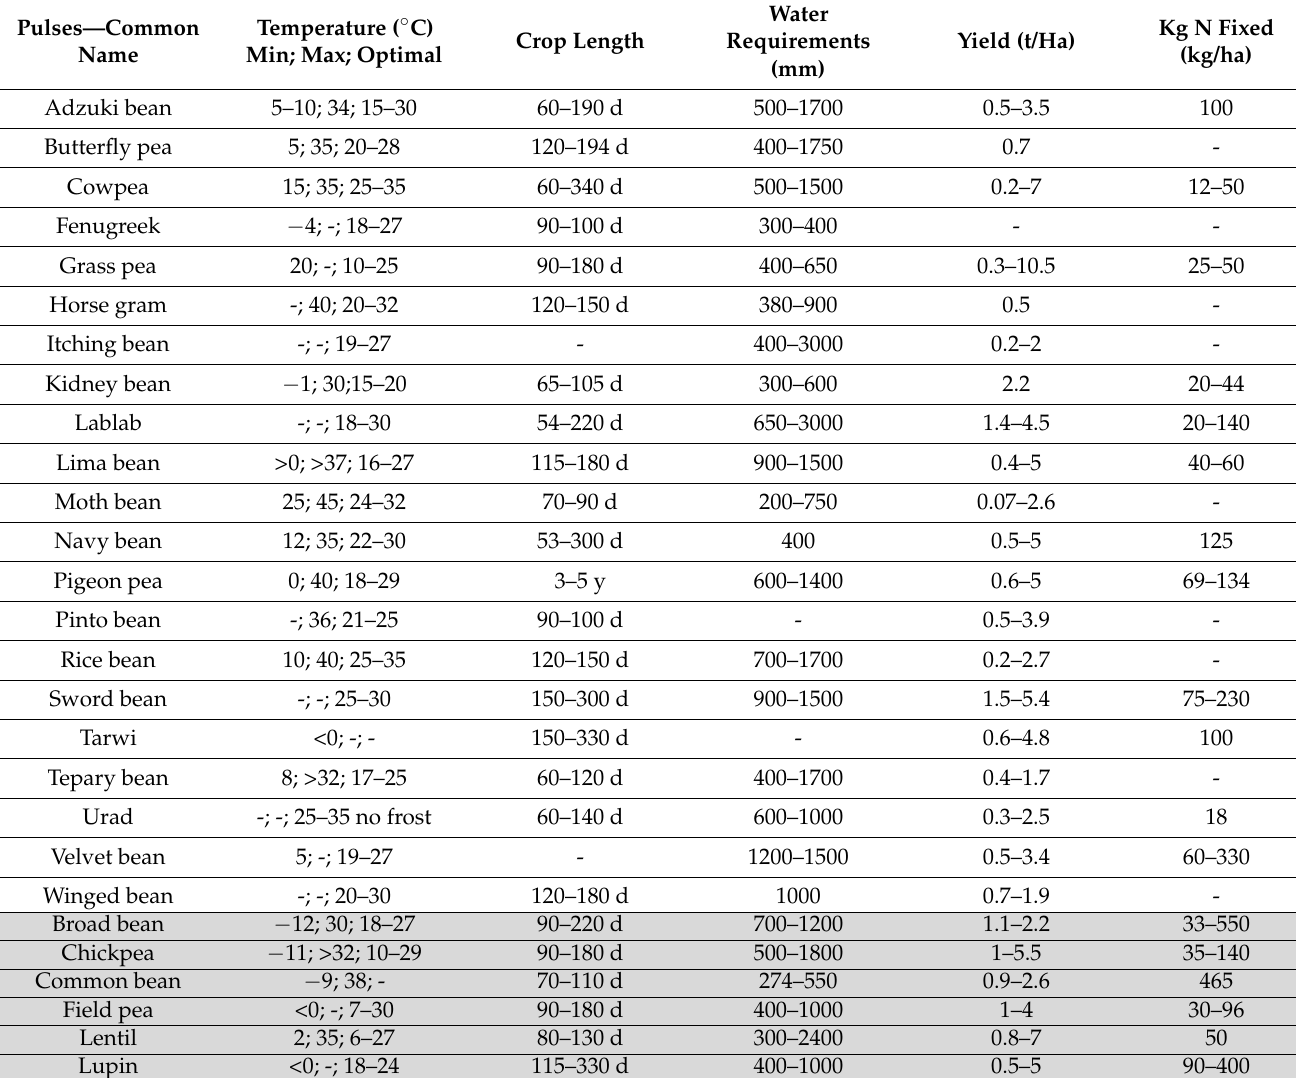
Table 3. Pulses’ agronomic requirements and potential yields, extracted from Appendix A.—indicates that no data were retrieved from the